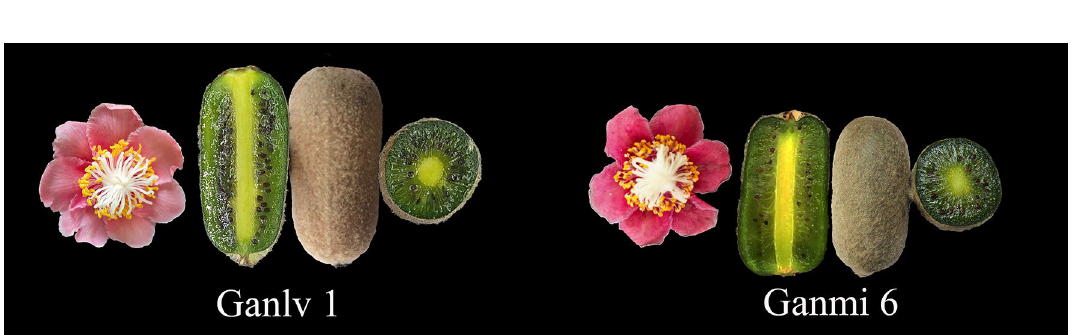
Figure 2. Morphology of flower, leaf and fruit of two